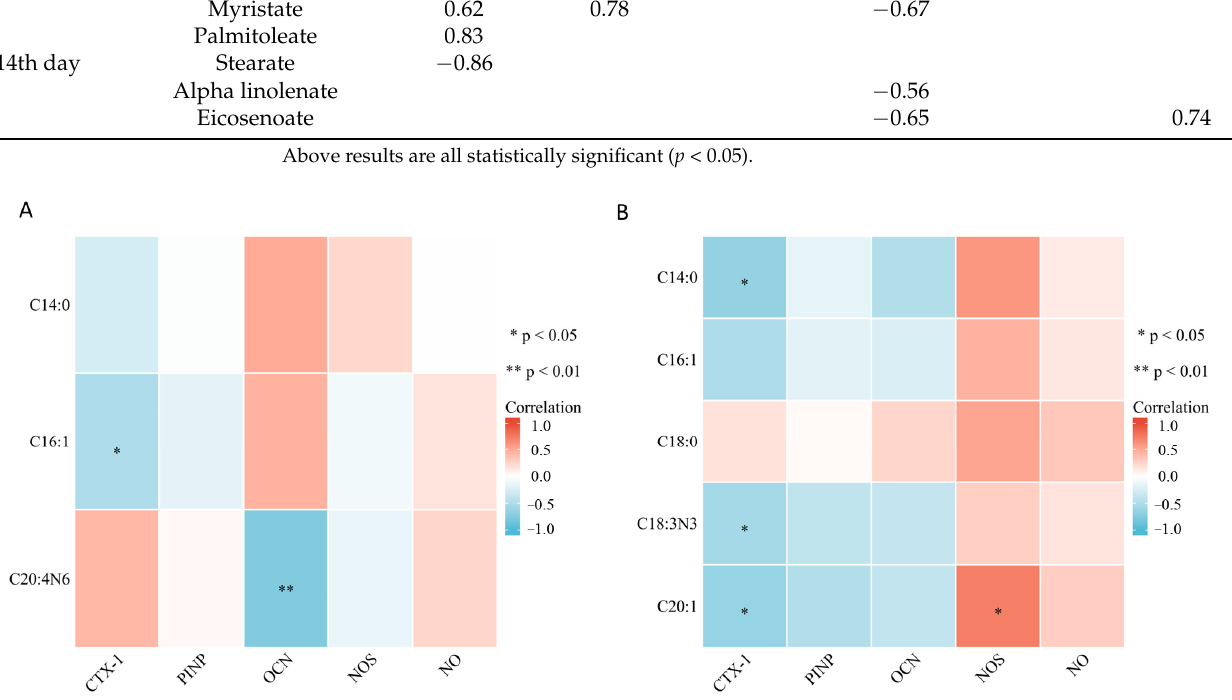
Figure 6. Correlation between differential fatty acids and serum bone metabolism-related parameters and the NOS/NO system. ( A ) Correlation between differential fatty acids and serum bone metabolism-related parametersand the NOS/NO system on the 3rd day after surgery. ( B ) Correlation between differential fatty acids and bone metabolism-related parameters and the NOS/NO system on the 14th day after surgery. * p < 0.05 and ** p < 0.01 suggest a statistically significant correlation. Color key indicates the correlation coefficients, red, positive correlation, blue, negative correlation. Table 2. Correlation coefficients of significant differential fatty acids with bone microstructure and bone metabolism related parameters.